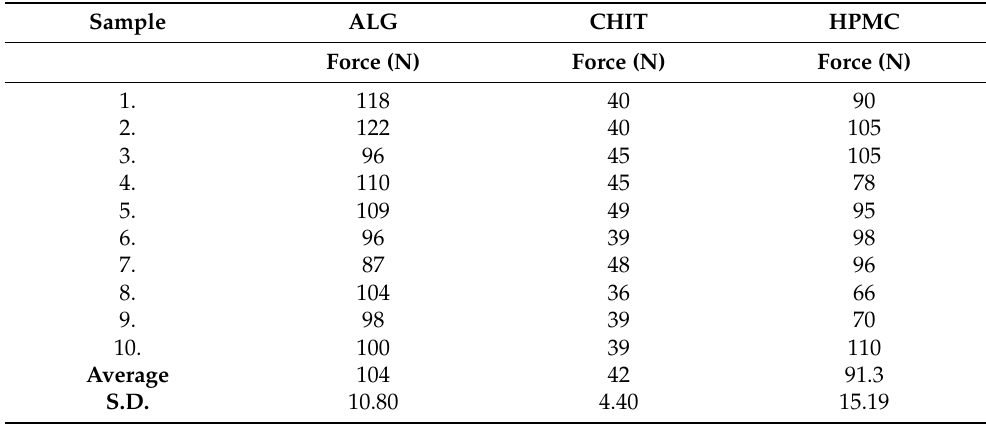
Table 6. Resistance to crushing of the MUPS tablets produced from pellets containing sodium alginate (ALG), chitosan (CHIT), or hydroxypropyl methylcellulose (HPMC) as a